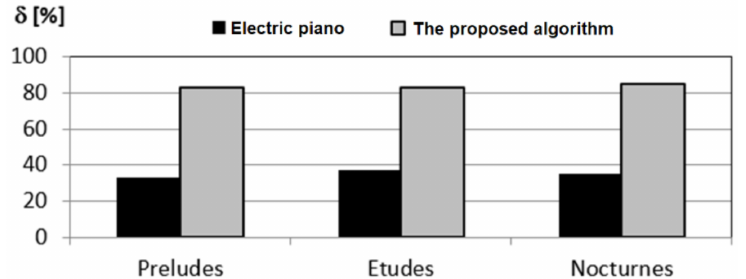
Figure 11. Comparison of the efficacies δ , defined as the percentage of the music pieces for which the key signature was correctly recognized, obtained for the proposed key signature recognition algorithm and the algorithm implemented in an electronic music instrument, based on F. Chopin’s preludes, etudes, and nocturnes.